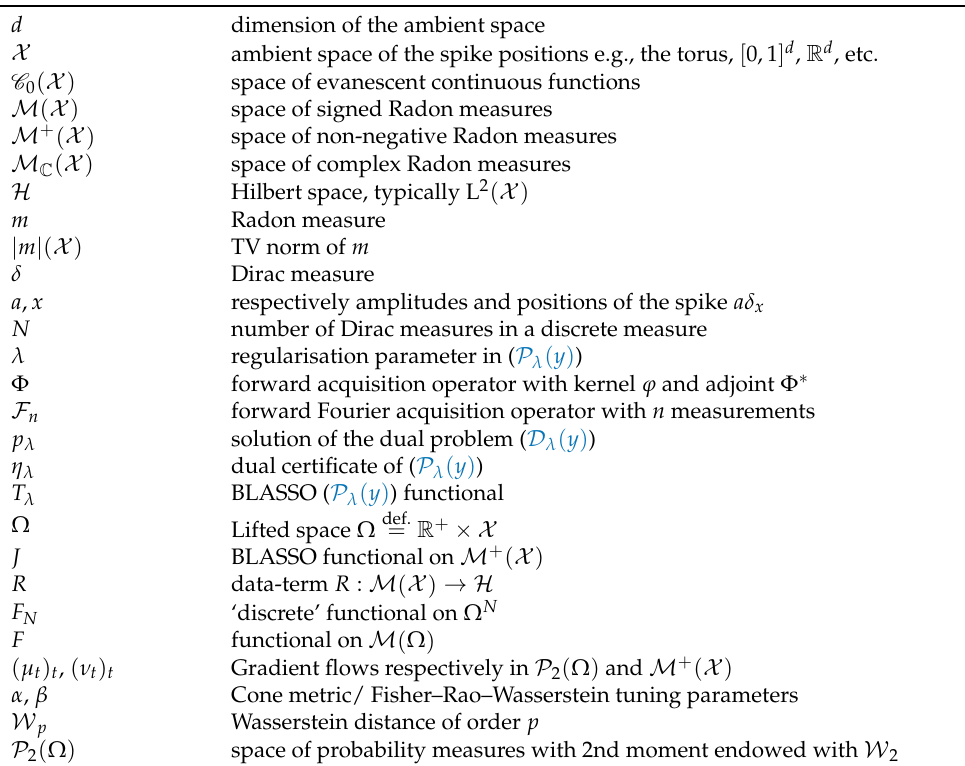
Table A1. Main notations used in the